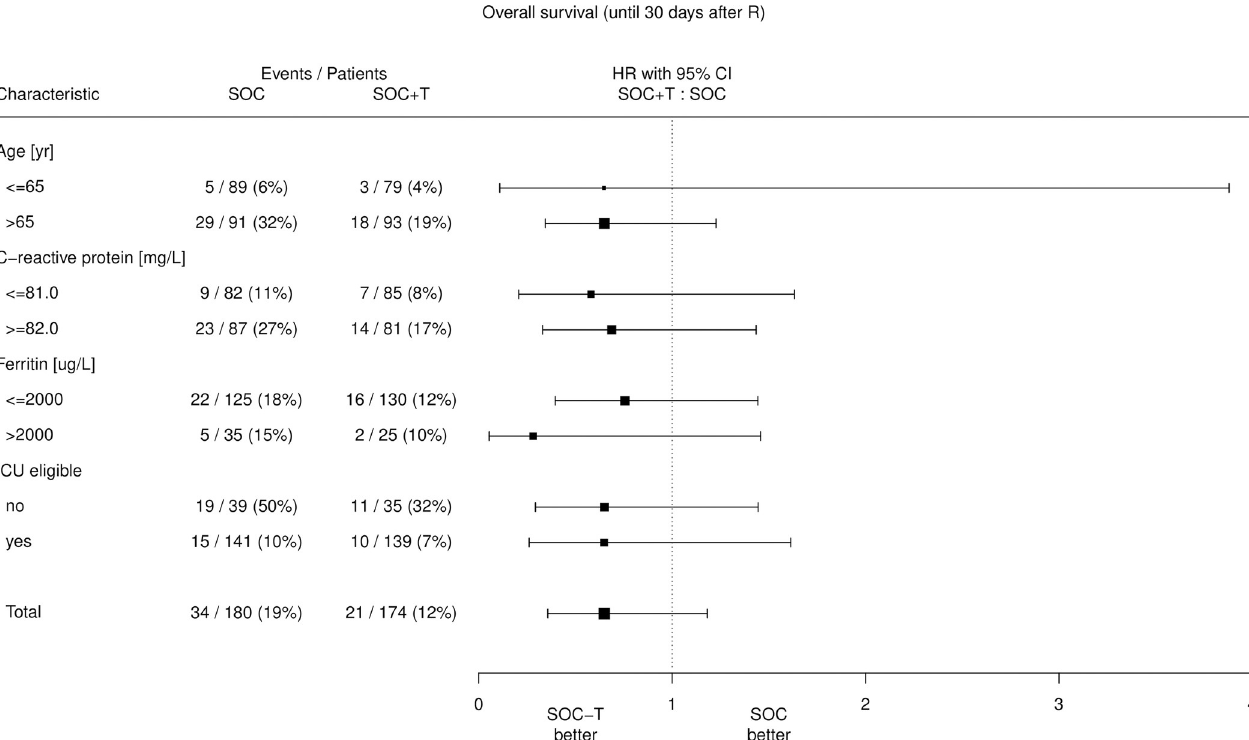
Fig 3. Forest plot. R = randomization, SOC = Standard of care, SOC+T = SOC with tocilizumab, ICU = intensive care unit, HR = hazard ratio, CI = confidence interval.